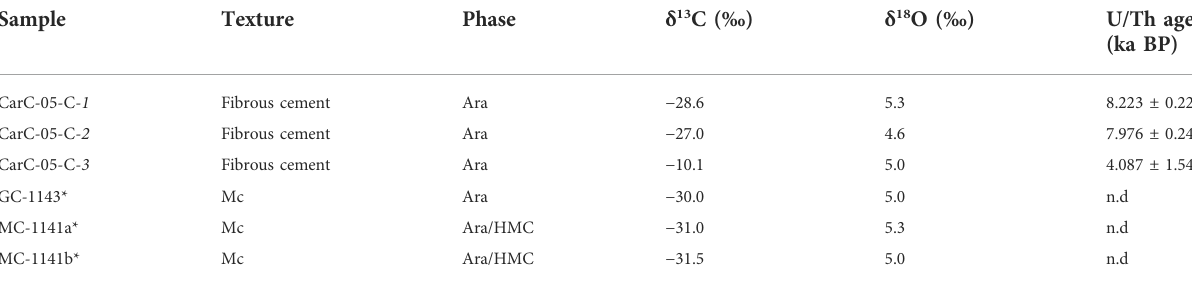
TABLE 1 Isotopic composition of methane-derived carbonates from Leirdjupet Fault Complex and U/Th ages.